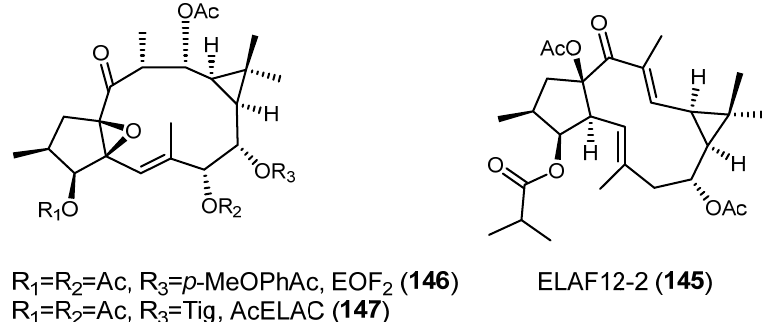
Figure 26. Structure of lathyrane tested on neurogenesis promotion activity.